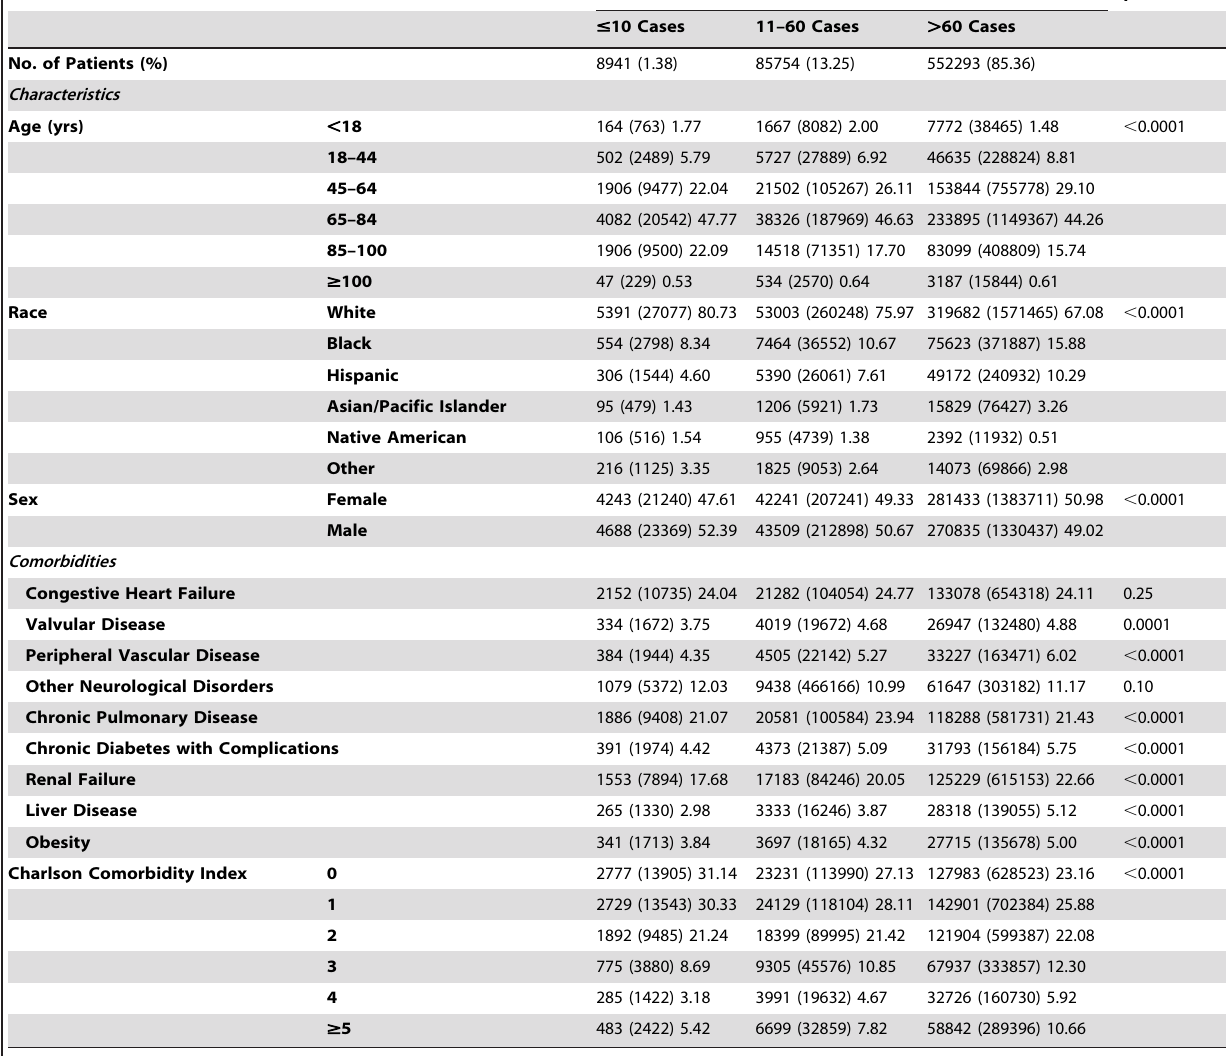
Table 1. Patient Characteristics at